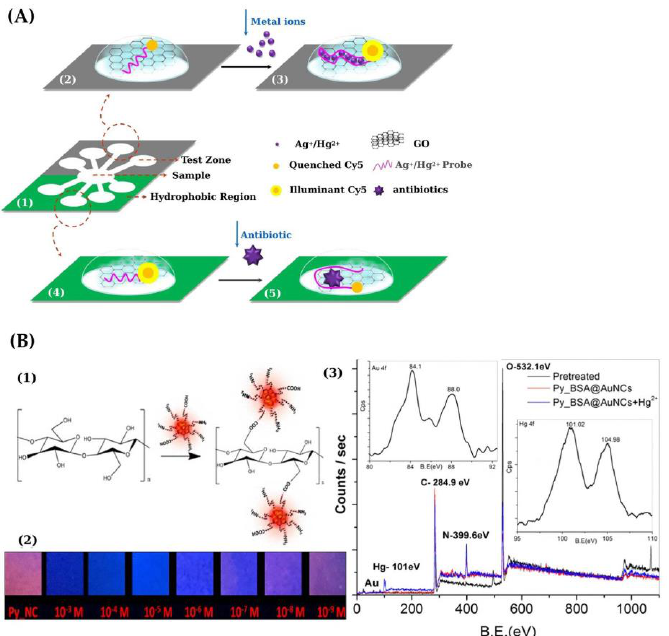
Figure 7. ( A ) Scheme showing a μ -PAD for multiplex detection of chemical contaminants using ssDNA-functionalized GO sensors. (1) Design of the μ -PAD. (2) and (3) show the metal ions detec- tion mechanism based on the interaction among GO, ssDNA and heavy metals; quenching of the fluorescence occurred when Cy5-labeled ssDNA was adsorbed on the GO surface (2, fluorescence OFF). In the presence of the metal ions, ssDNA spontaneously released from the GO surface yielding fluorescence recovery (3, fluorescence ON); (4) and (5) show the principle of antibiotic detection based on the interaction between GO, ssDNA and antibiotics; the fluorescence was partly quenched when Cy5-labeled ssDNA was adsorbed with low GO concentration (4, fluorescence ON); in the presence of the aminoglycoside antibiotic, the antibiotic-probe duplex increased the bind effect be- tween the duplex and GO surface through amide coupling, yielding a decrease in fluorescence in- tensity (5, fluorescence OFF) [87]. ( B ) (1) Schematic diagram showing the preparation of a paper- based sensor with Py_BSA-AuNCs as receptors; (2) fluorescence color changes observed on test pa- per strips with Py_BSA-AuNCs following interaction with Hg(II) at different concentration (1 mM – 1 nM) under UV light at 365 nm; (3) XPS spectrum of Py_BSA-AuNCs before and after addition of Hg(II) (Inset showing the XPS spectrum of the Au 4f band and Hg 4f band) [88]. Figure 7A,B is reproduced with permission of Elsevier [87,88].